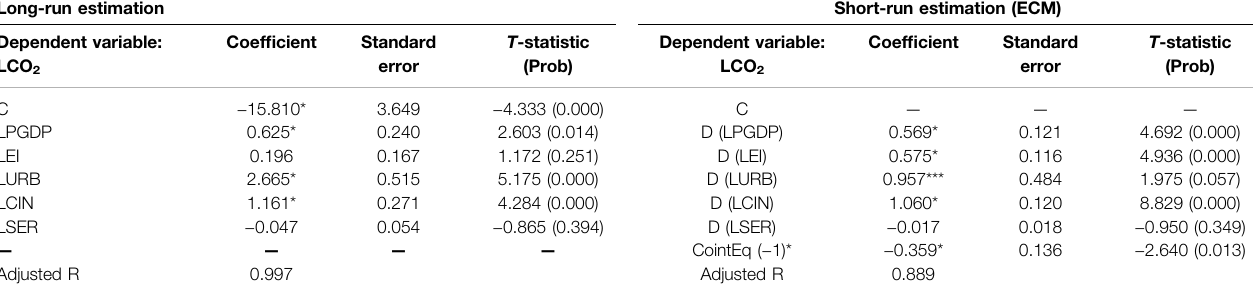
TABLE 5 | The long- and short run estimated results of the ARDL (1,1,2,2,1,0) model. Long-run estimation Short-run estimation